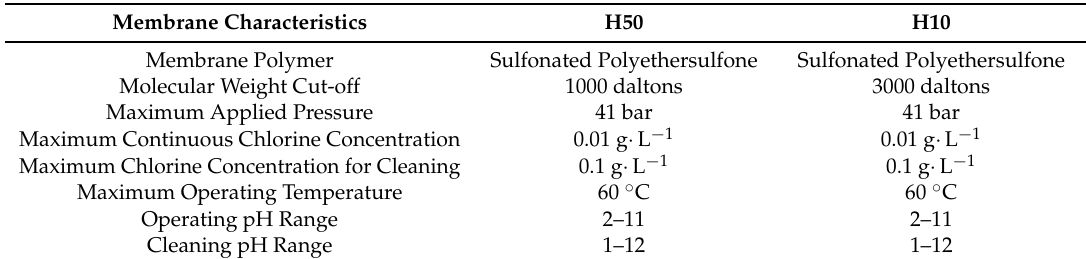
Table 1. H50 and H10 specifications.